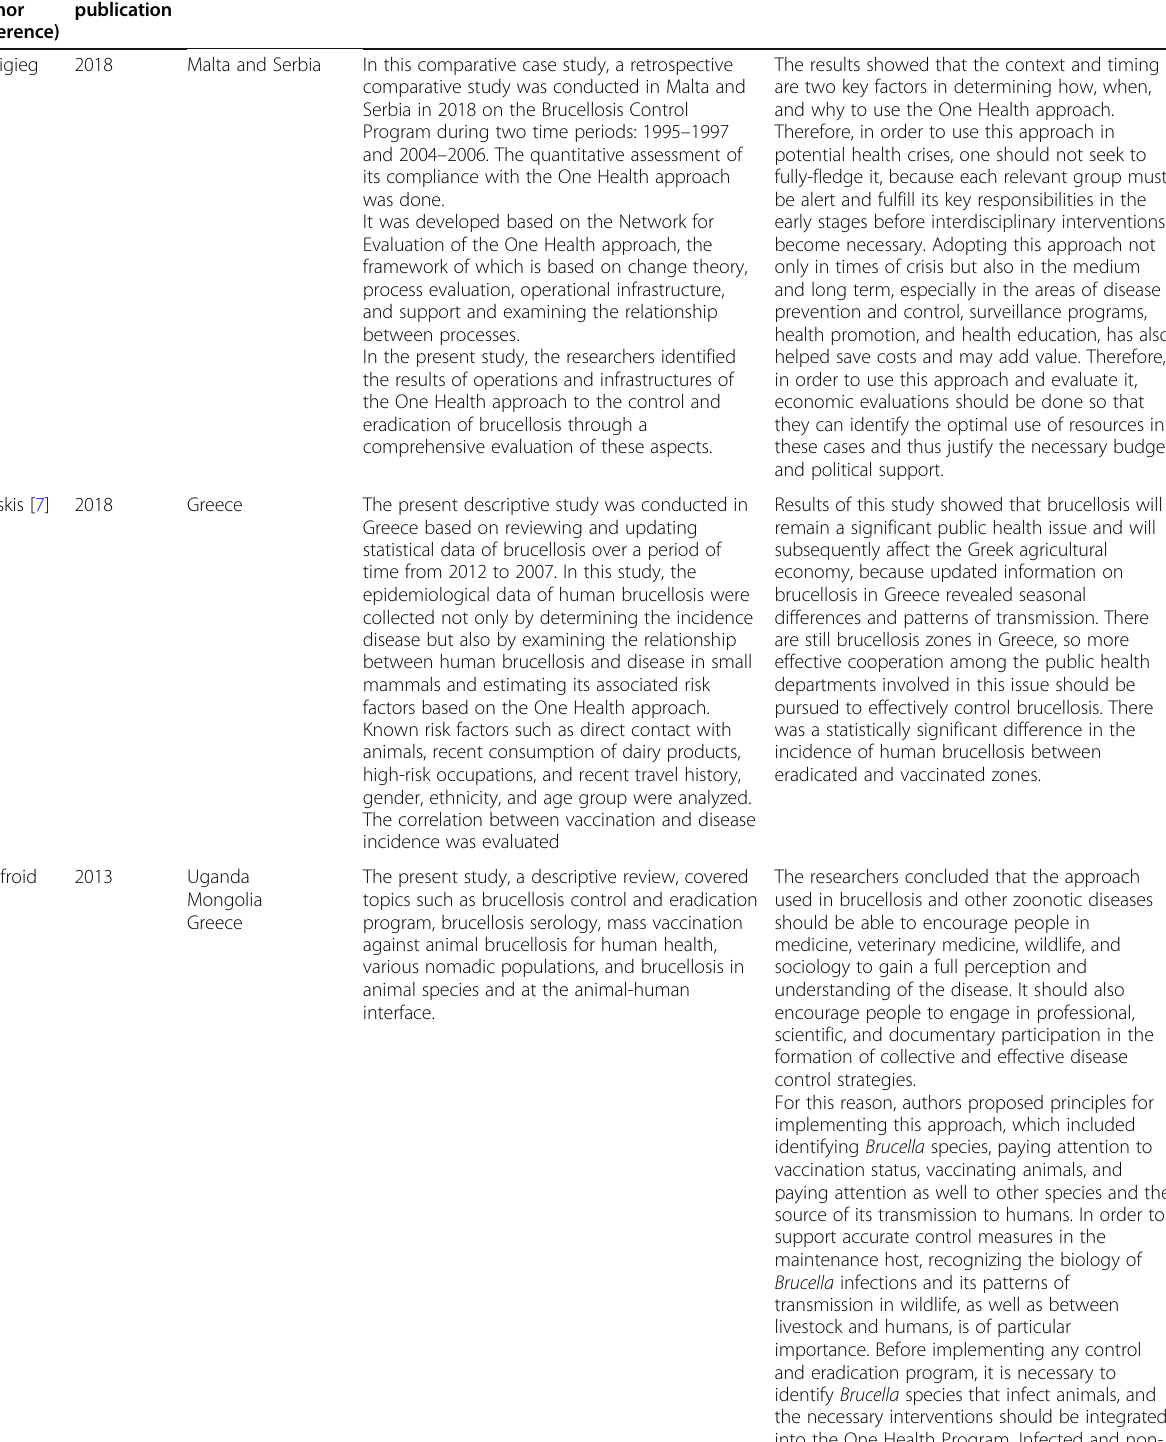
Table 1 Characteristics of the included